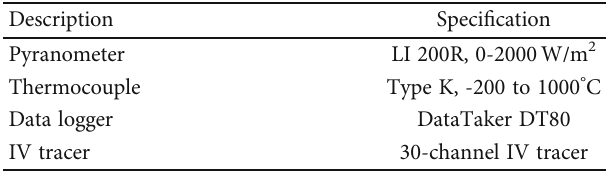
Figure 3: Experimental setup of the polycrystalline and monocrystalline PV panels. Table 1: Details of the components.